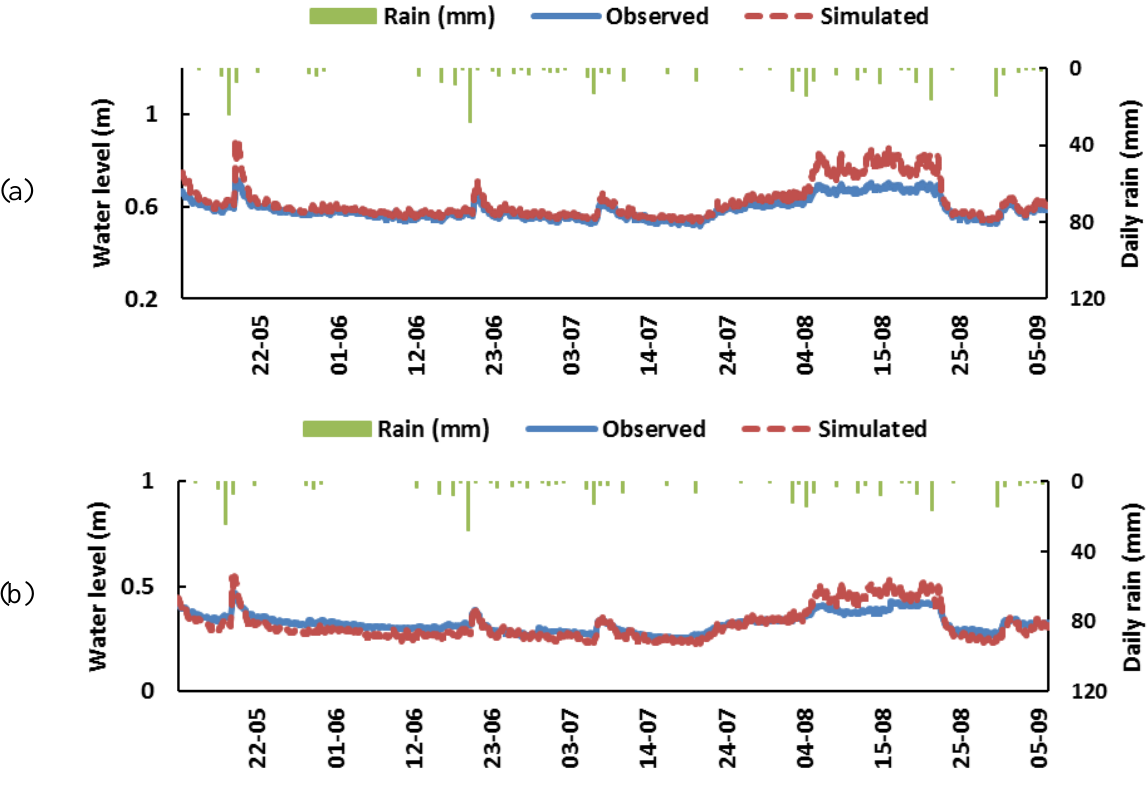
Figure 9. Time series (hourly) of observed and simulated water levels (a) upstream and (b) downstream of Basin